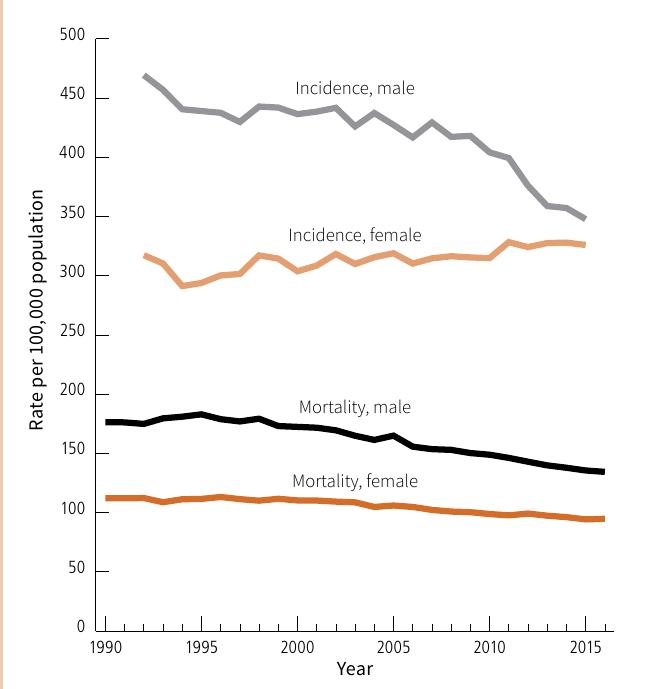
Figure 3. Trends in Incidence and Death Rates for All Cancers Combined among Hispanics, US,